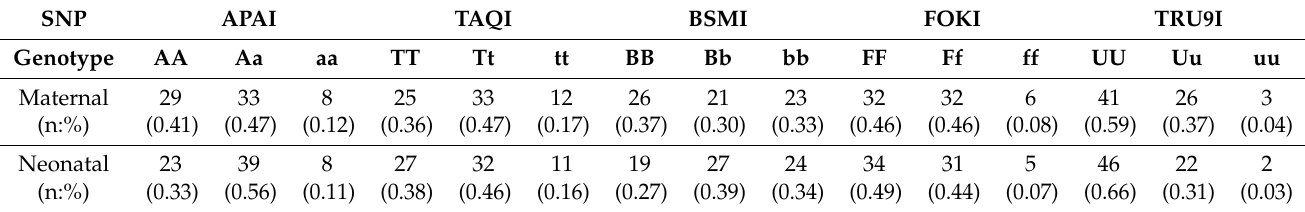
Table 2. Vitamin D receptor single nucleotide polymorphisms genotype distributions of mothers and neonates.